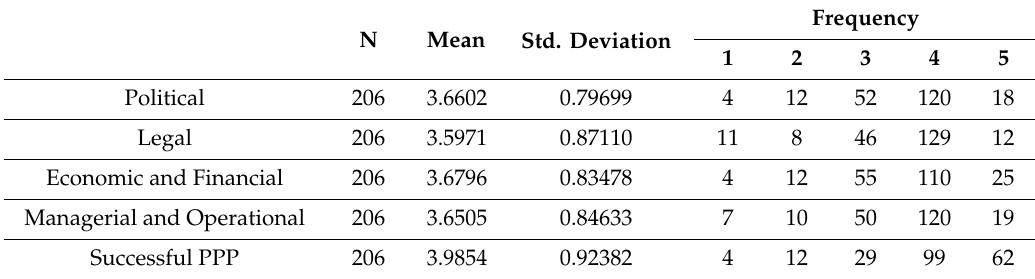
Table 8. Descriptive analysis for the research